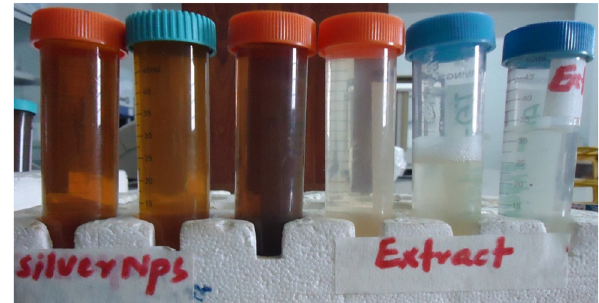
Figure 1: Digital optical images of synthesized silver nanoparticles color change of silver nitrate to silver